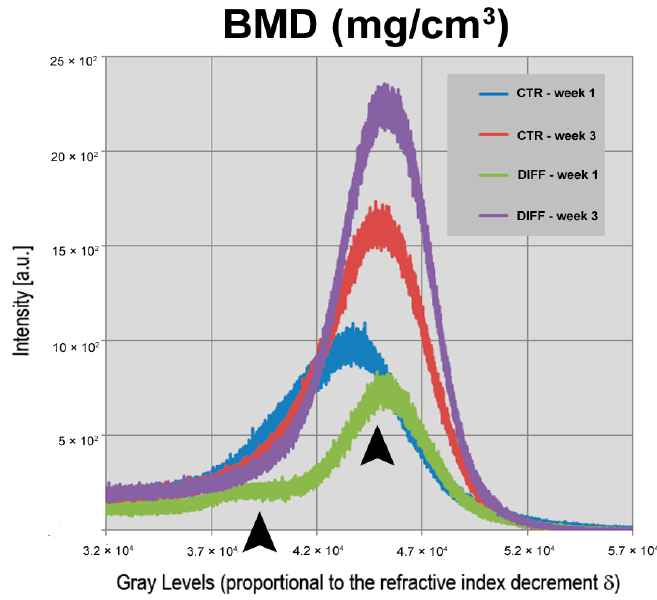
Figure 2. Portion of the “intensity counts vs. gray levels” profiles. The grey levels are proportional to the refractive index decrement δ , nearly proportional to the physical density ρ of the newly formed mineralized phase. The integrated areas of the represented peaks correspond to the volumetric amount of the newly formed mineralized bone in scaffolds cultured in basal and differentiating xeno-free media. The two black arrowheads show the two different levels of mineralization after the first week of culture.